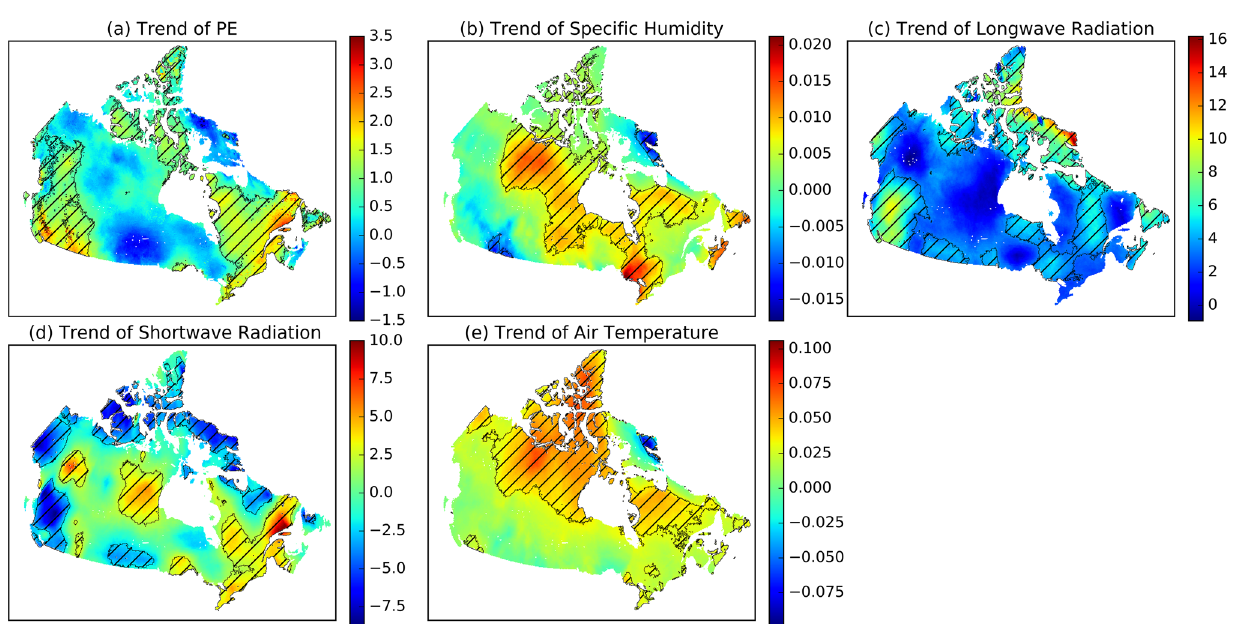
Figure 8. The trends of annual potential evaporation (PE) and climate variables in 1979–2016 in Canada indicated by the Sen’s slope of ( a ) PE (mm/year), ( b ) specific humidity (g /kg/year), ( c ) downward longwave radiation (MJ/m 2 /year), ( d ) downward shortwave radiation (MJ/m 2 /year), and ( e ) air temperature (°C/year) (Hatching indicates that the trends are significant at the 95% confidence interval. The map was created using our own script in Anaconda Python 3.8 downloaded from https ://docs.anaco nda.com/anaco nda/insta